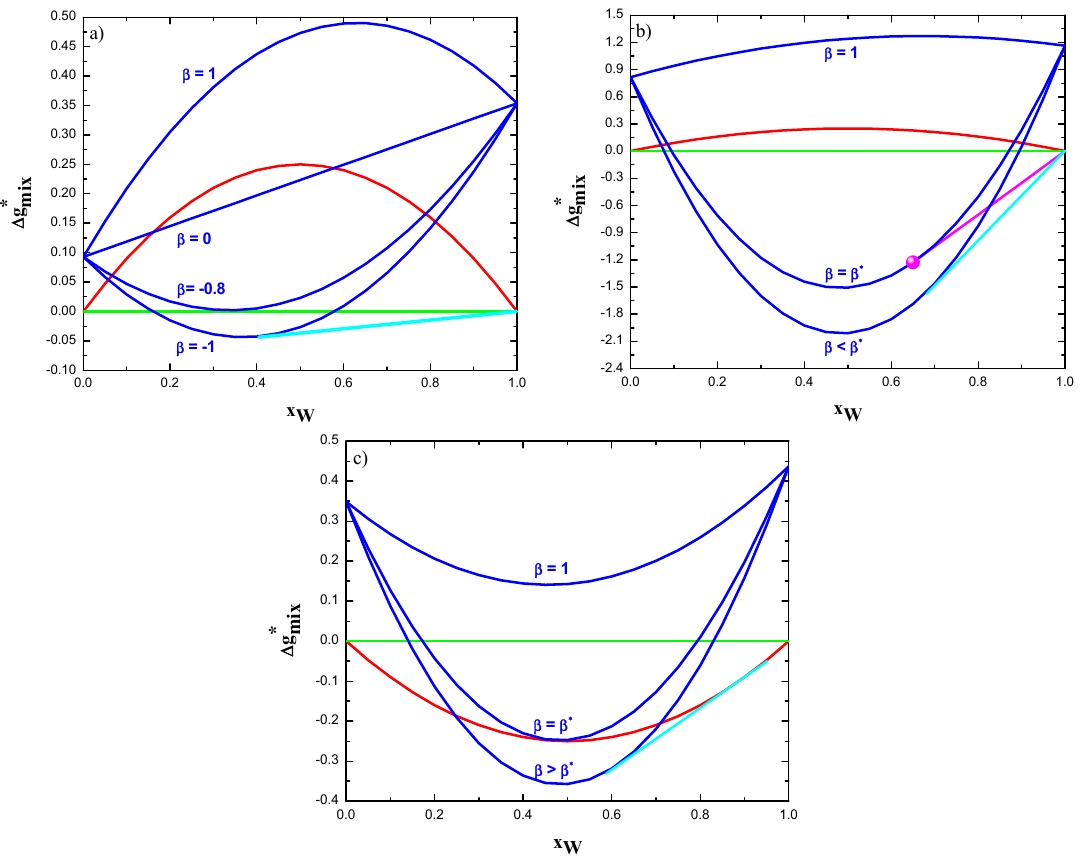
Figure 2. Phase equilibria of polycrystalline alloys: ( a ) W-Zn; ( b ) W-Zr; and, ( c ) W-Nb. Dimensionless Gibbs free energy as function of composition are reported for bulk solid solution (red), phase separated state (green), as well as grain boundary phase (blue). Latter one is depicted for di ff erent values of the coe ffi cient β . Polycrystalline stable states are given by the common tangent (cyan) between grain boundary phase and bulk solid solution. Purple common tangent describes instead the existence of intermetallic-containing states. The point (magenta) characterizing the stoichiometric intermetallic compound W 2 Zr is also shown in figure